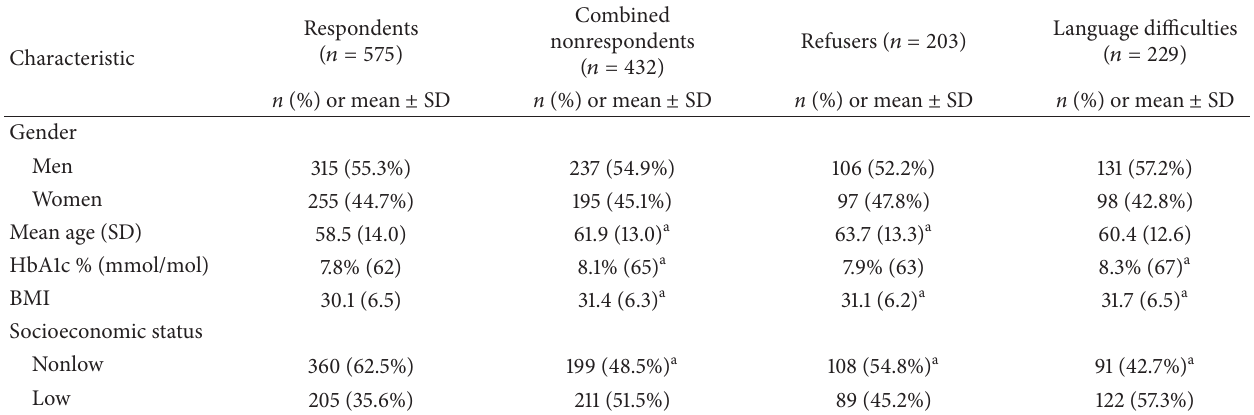
Table 1: Demographic characteristics of respondents ( 𝑛 = 575 ) and nonrespondents ( 𝑛 = 432 ) divided by reason of